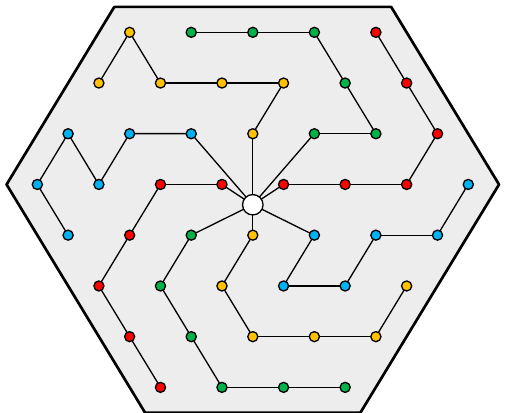
Figure 4. Brædstrup borehole thermal energy storage (BTES) system layout and serial BHE connections [33].